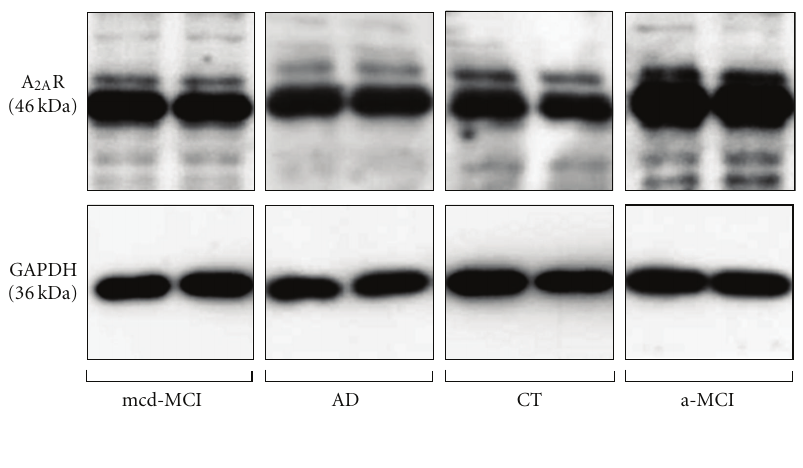
Figure 2: Paradigmatic example of the Western blot analysis of the A 2A R densities in PBMC extract from one subject belonging to the AD, a-MCI, mcd-MCI, or control (CT) group, run in duplicate.